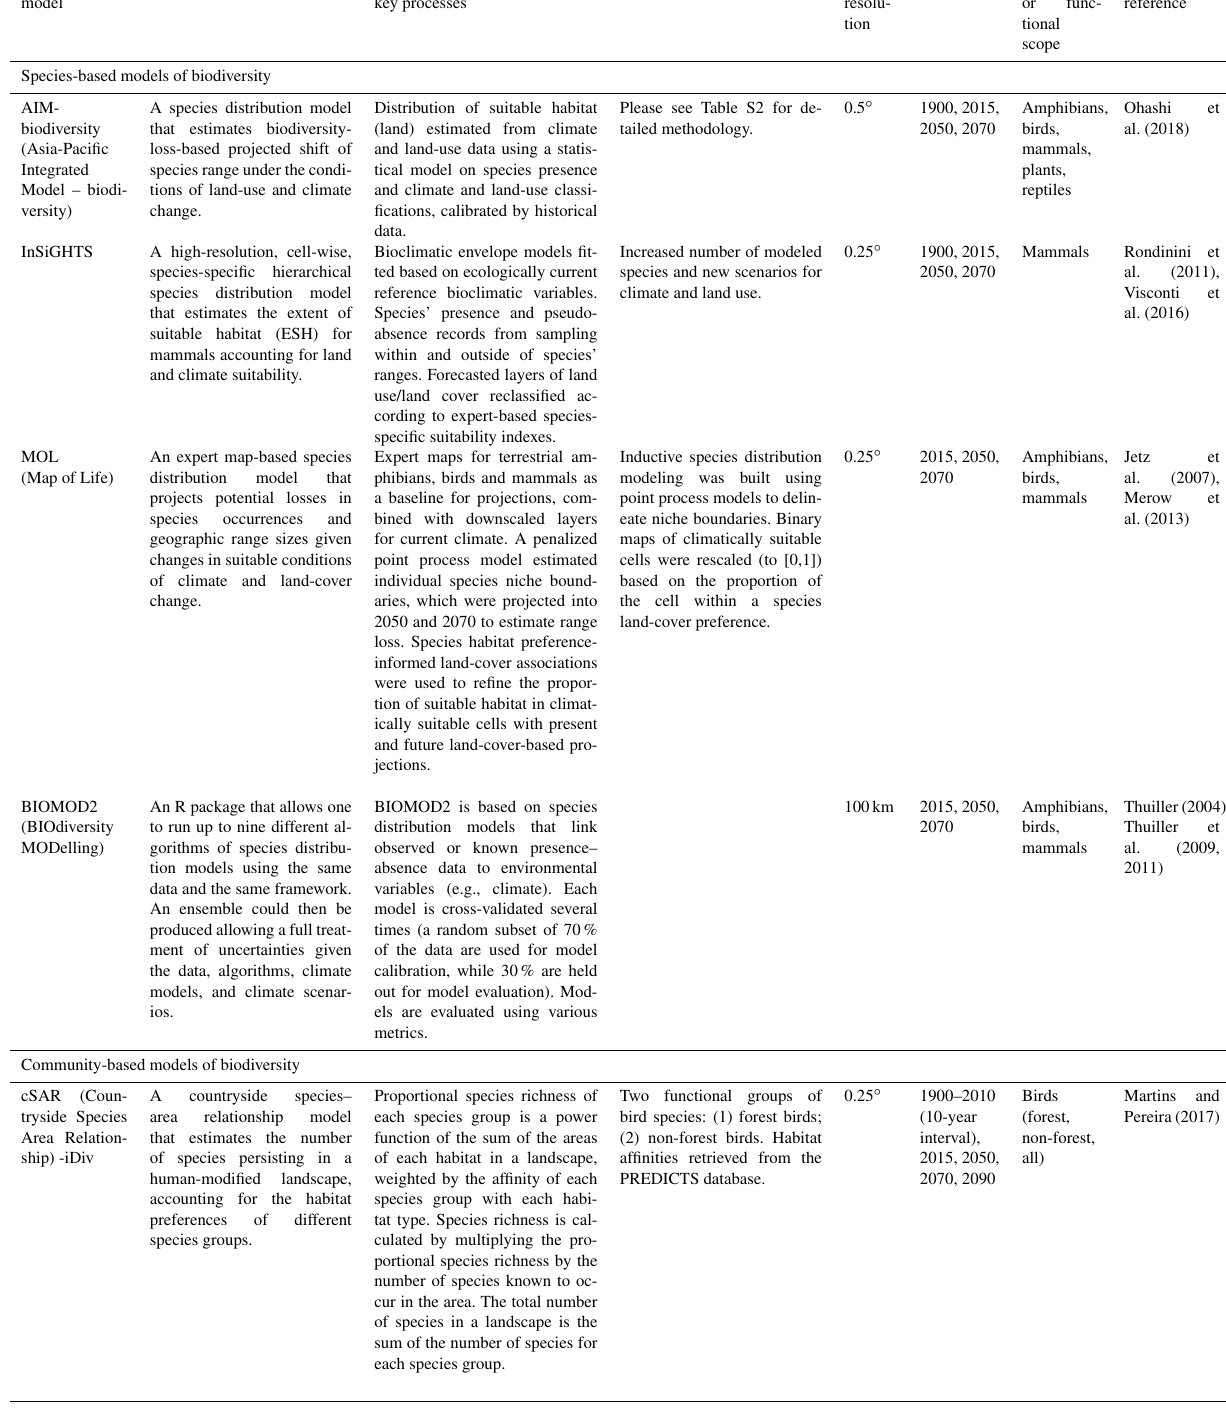
Table A1. Description of biodiversity and ecosystem functions and services models in